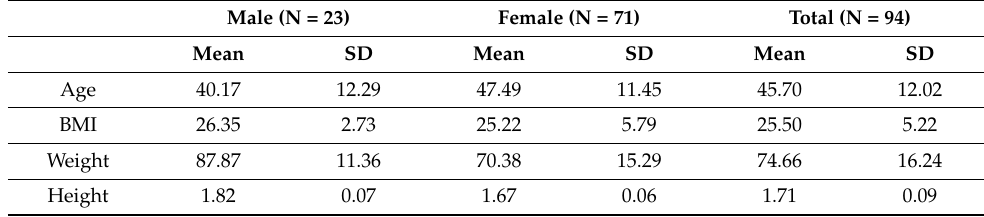
Table 1. Demographyofrespondents. BMI:bodymassindex; N:numberofsubjects; SD: standard deviation.